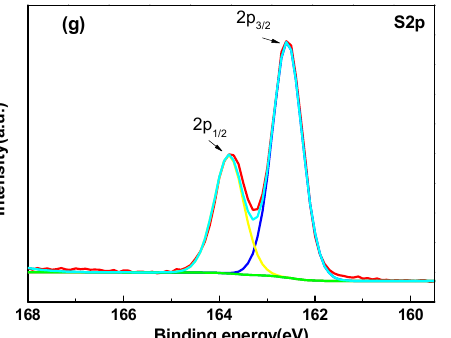
Figure 3. XPS spectra of MoS 2 and KH560-MoS 2 ( a ), high-resolution XPS spectra of C1s ( b ); O1s ( c ); Mo3d ( d ); S2p ( e ) for KH560-MoS 2 , and Mo3d ( f ); S2p ( g ) for MoS 2 .